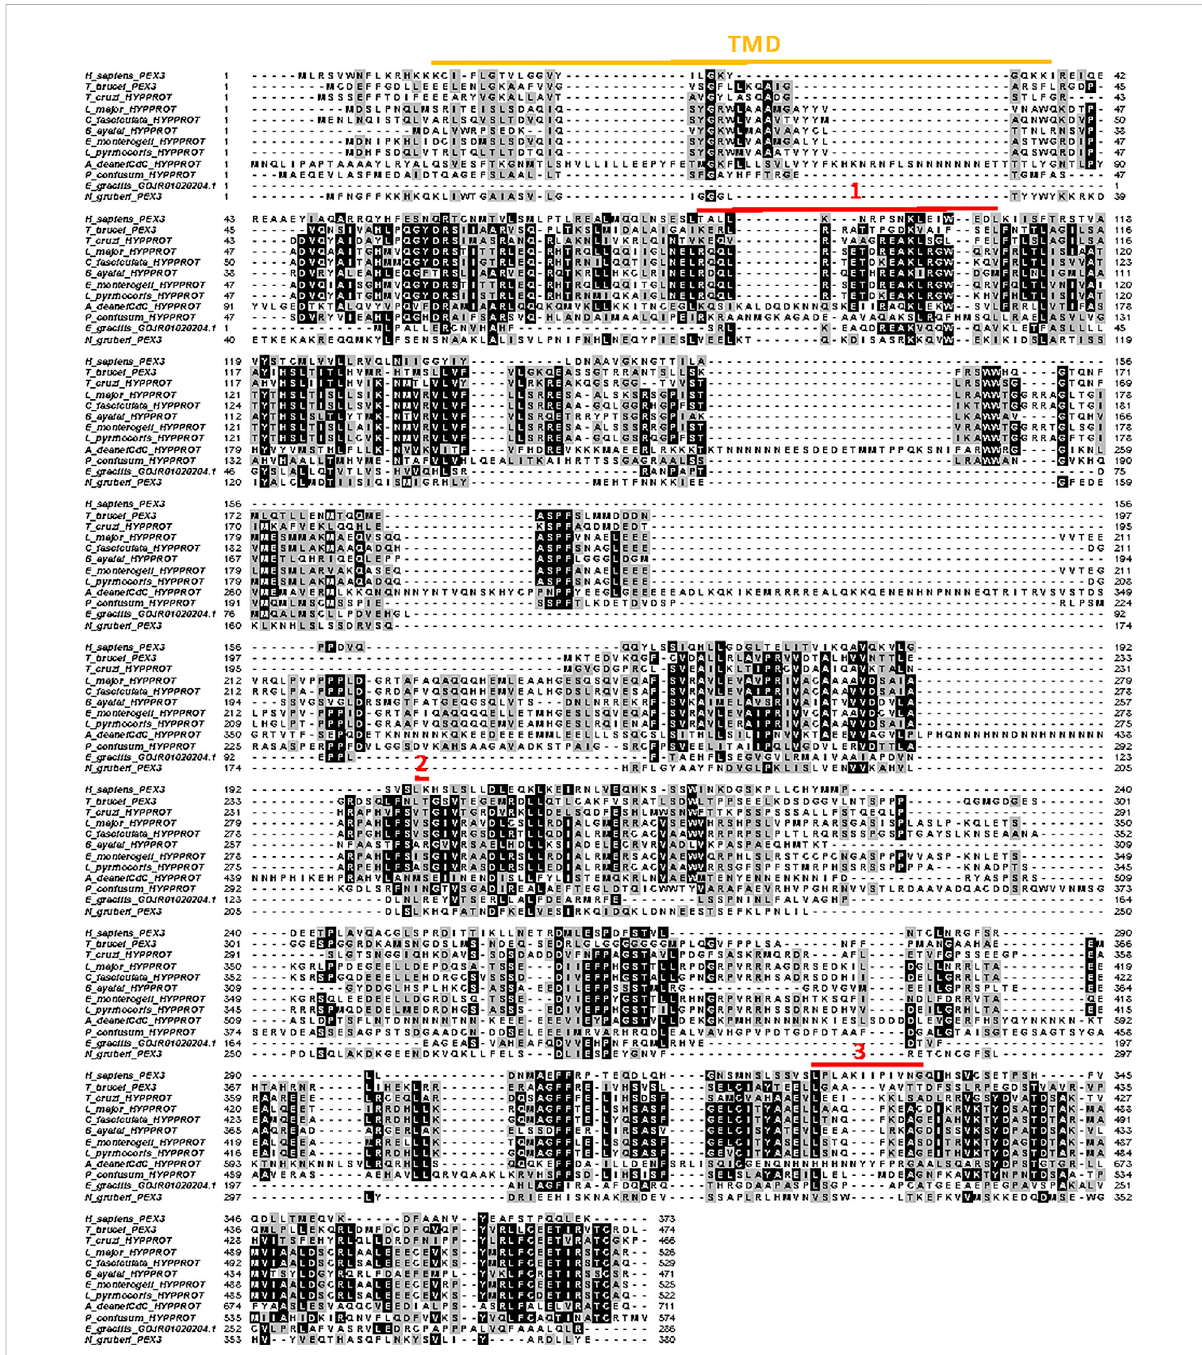
FIGURE 7 Alignment of PEX3 amino-acid sequences from selected Euglenozoa, Naegleria and human. Sequence IDs: H. sapiens : P56589; T. brucei : Tb927.11.10260; T.cruzi :TcCLB.510,719.280 ;L.major :LmjF.36.4010; C.fasciculata :CFAC1_280044800; B.ayalai :Baya_134_0190; E.monterogeii : EMOLV88_360046900; L. pyrrhocoris : LpyrH10_06_1720; P. confusum : PCON_0042250; E. gracilis : GDJR01020204.1; N. gruberi : NAEGRDRAFT_68465. The transmembrane region is highlighted by the yellow line above the alignment, and the amino acids involved in PEX19 binding are indicated by red lines numbered 1 to 3 (Kalel et al., 2019). The alignment was made in